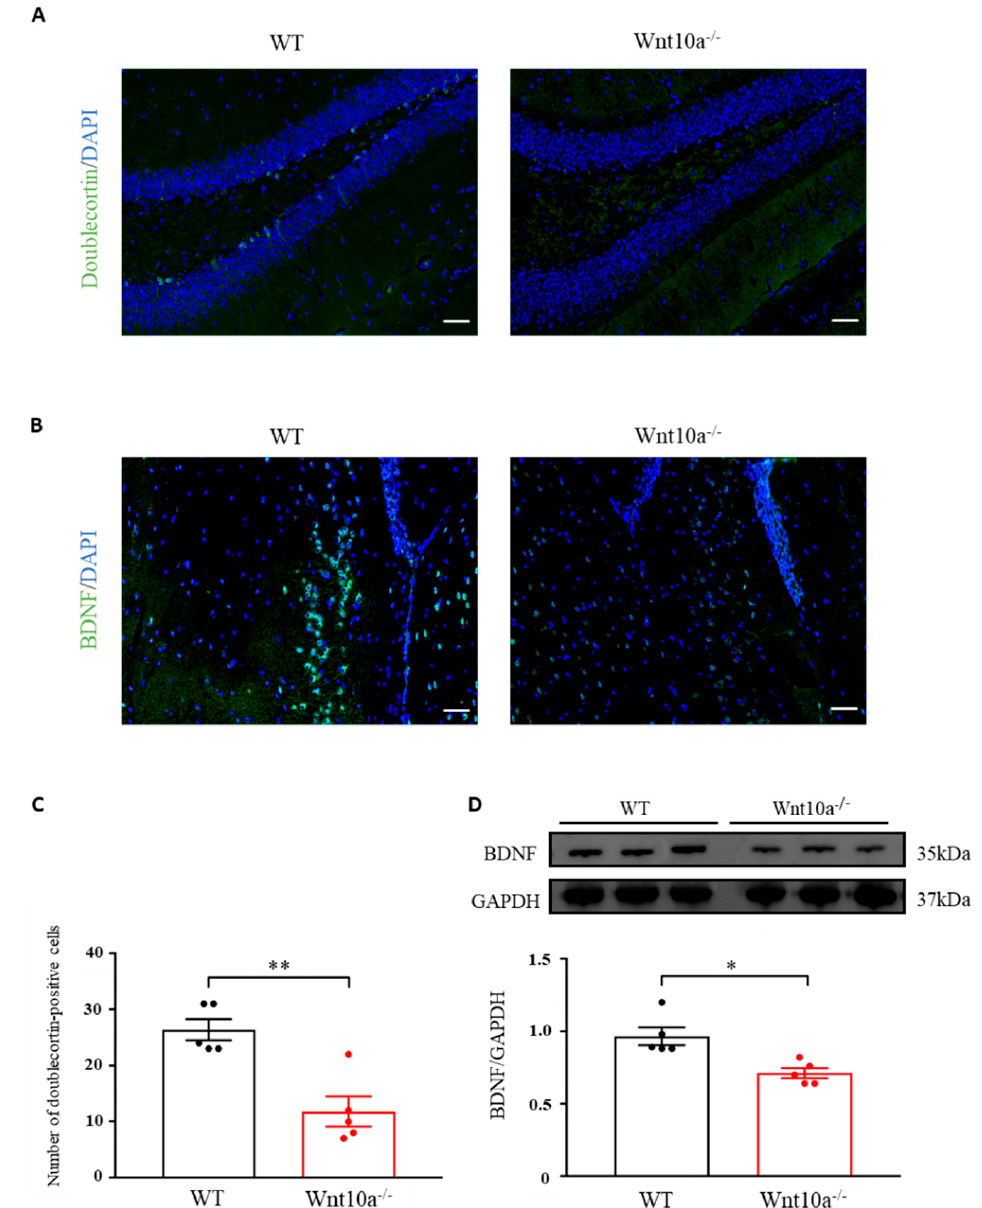
Figure 4. Immunofluorescence images of doublecortin and BDNF and the protein expression of BDNF in the hippocampus. The number of doublecortin-positive cells in the hippocampal dentate gyrus was significantly lower in Wnt10a -/- mice compared with WT mice ( A , C ). The expression of hippocampal BDNF was significantly lower than that of WT mice ( B , D ). Scale bars = 50 µ m in ( A ) and ( B ); data are expressed as mean ± SEM; n = 5/group; * p < 0.05 and ** p < 0.01.